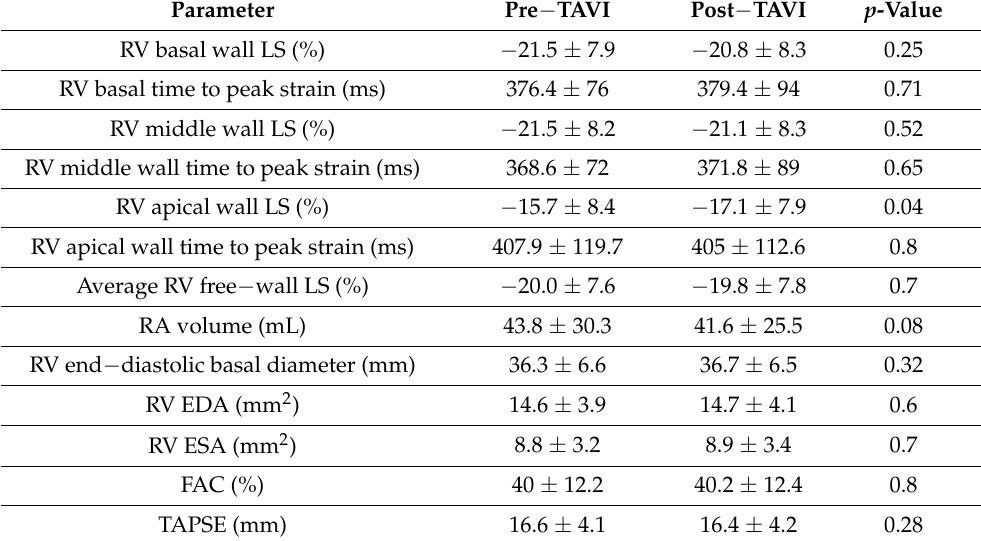
Table legend: RV: right ventricular, LS: longitudinal strain, EDA: end-diastolic area, ESA: end-systolic area, FAC: fractional area change, TAPSE: tricuspid annular plane systolic excursion. Table 3. Echocardiographic Predictors of Long-Term All-Cause Mortality.